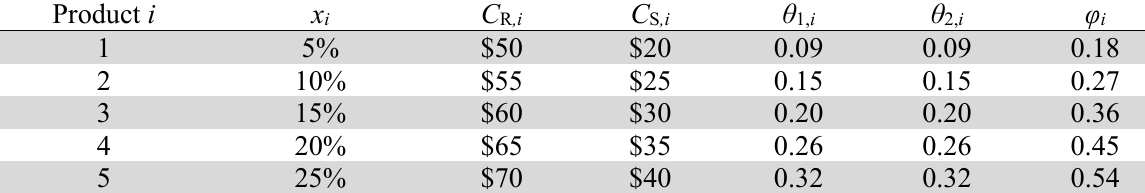
The parameters’ values of the same problem under a one stage production